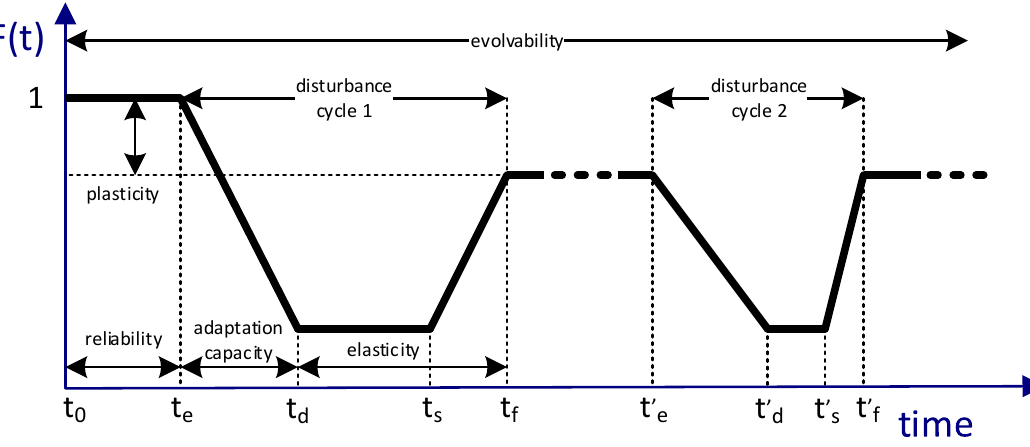
Figure 1. System performance variation during a disturbance and its characteristics (figure adapted from